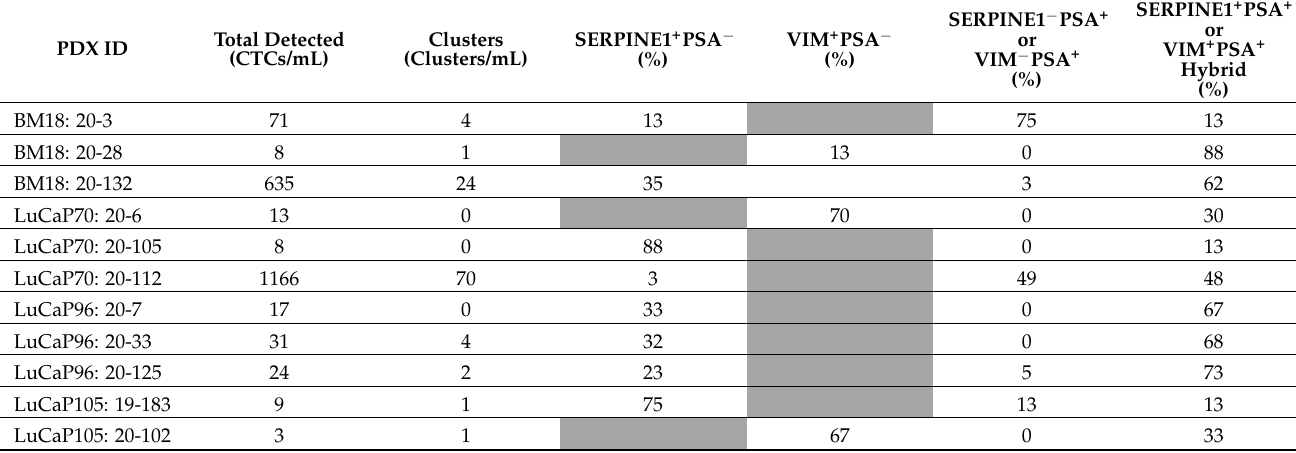
Table 5. Summary of circulating tumour cell VIM/SERPINE1/PSA immunofluorescence cytology for all PDX blood